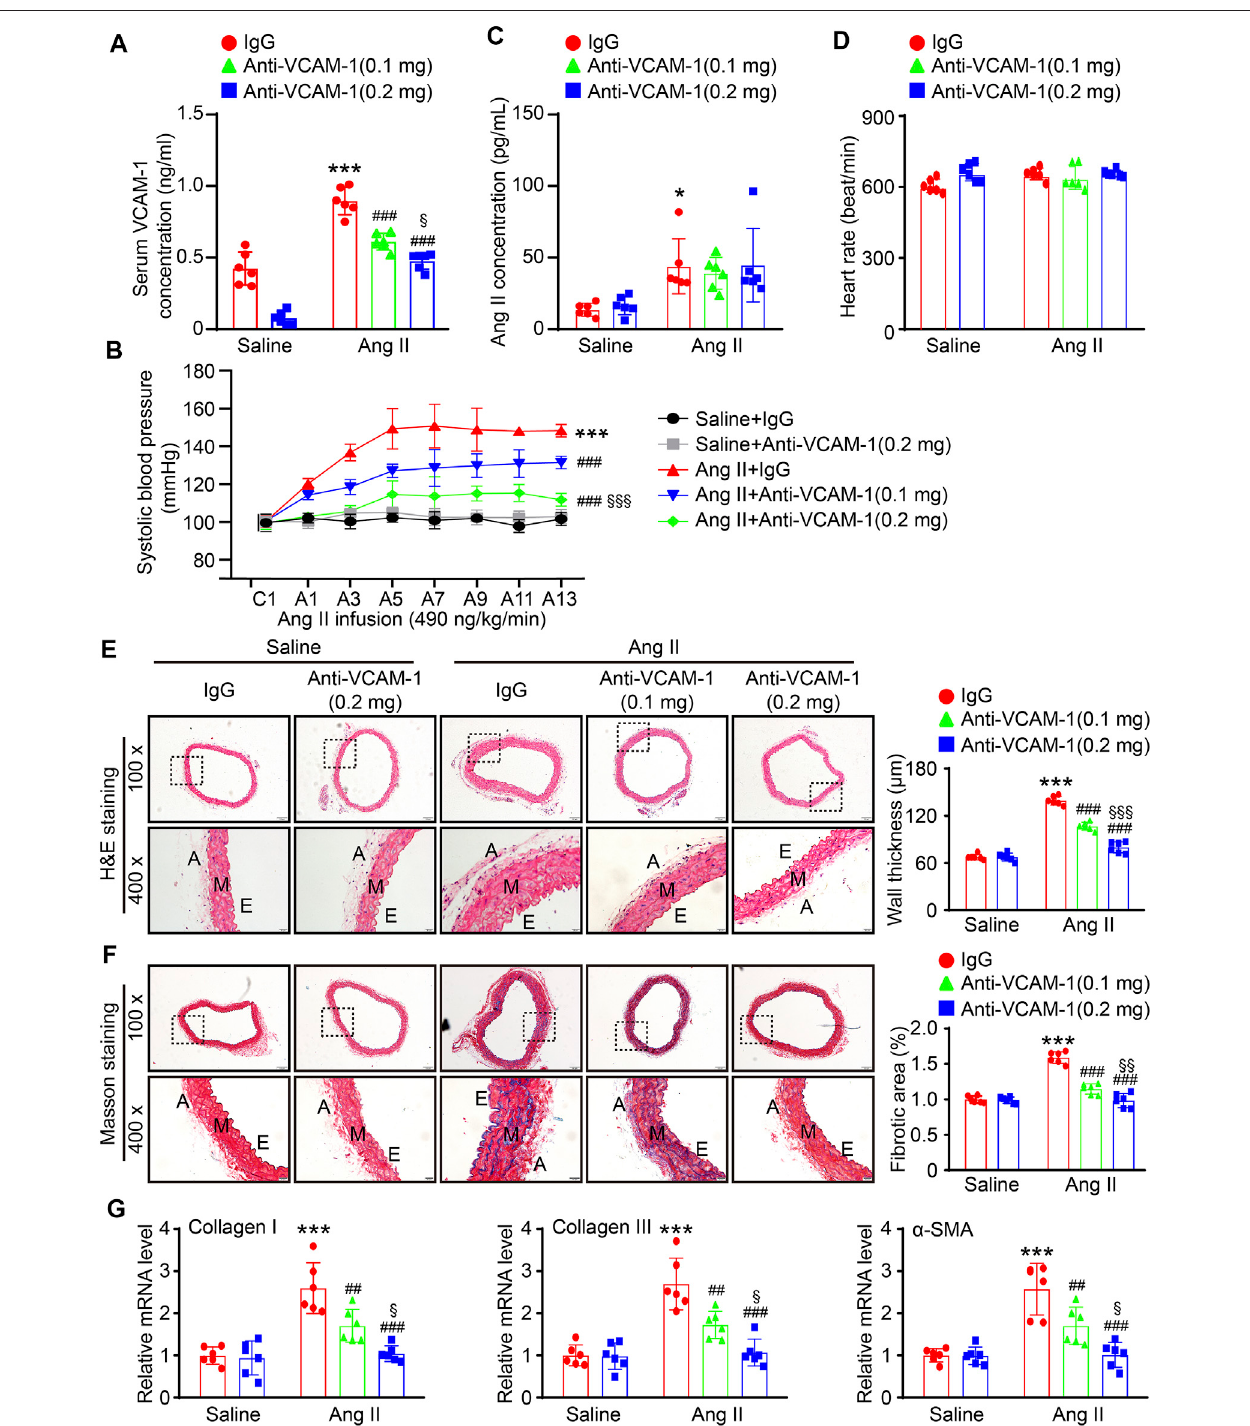
FIGURE2| InhibitionofVCAM-1preventsAngII-inducedhypertension,hypertrophy,and fi brosisintheaorta. (A) WTmiceweretreatedwithaVCAM-1neutralizing antibody (0.1 or 0.2 mg/mouse) or IgG control and infused with Ang II (490 ng kg − 1 min − 1 ) or saline for 14 days. Analysis of the serum VCAM-1 concentration in each group ( n = 6). (B) Analysis of aortic SBP during Ang II infusion ( n = 6). (C) Analysis of the serum Ang II concentration in each group ( n = 6). (D) Measurement of the heart rateineach group( n =6). (E) H&Estainingoftheaortaat100x(upper,scalebar=100 μ m)and400x(lower,scalebar =20 μ m)andquanti fi cationofwallthickness (right, n = 6). (F) Analysis of collagen deposition in the aorta by Masson staining at 100x (upper, scale bar = 100 μ m) and 400x (lower, scale bar = 20 μ m) and quanti fi cationofthe fi broticarea(right, n =6). (G) qPCRanalysisofcollagenI,collagenIIIand α -SMAmRNAlevels( n =6).Thedataareexpressedasthemean±SD,and n represents the number of samples. * p < 0.05 and *** p < 0.001 versus saline; ## p < 0.01 and ### p < 0.001 versus Ang II + IgG; § p < 0.05, §§ p < 0.01 and §§§ p < 0.001 versus Ang II + anti-VCAM-1 (0.1 mg).